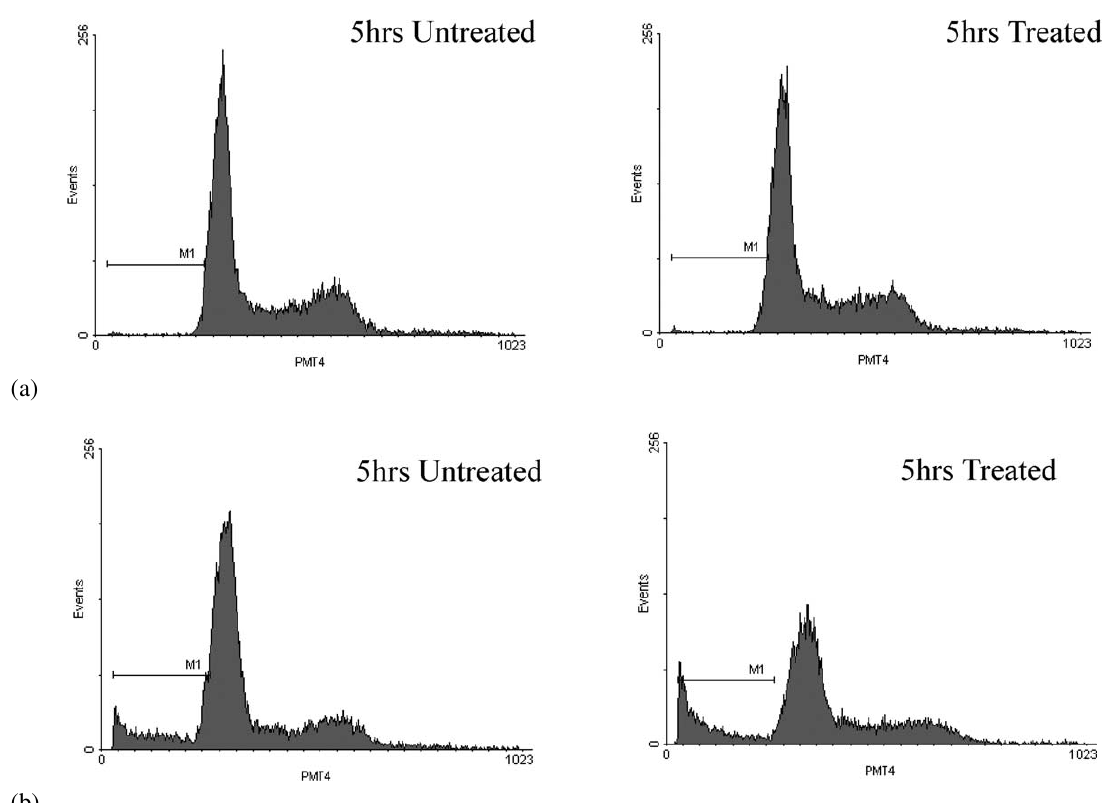
Fig. 3. (a) DNA histograms of Sw620 cells at 5 hrs showing the percentage of cells in the sub-G0/G1 gate, M1. This population increased from 3.7% in the untreated cells to 7.5% in treated cells. Also note widening of peak in the treated sample. (b) DNA histograms of Sw480 cells at 5 hrs showing the percentage of cells in the sub-G0/G1 gate, M1. This population increased from 18.3% in the untreated cells to 26% in treated cells. age, values can range from 0 = black to 255 =